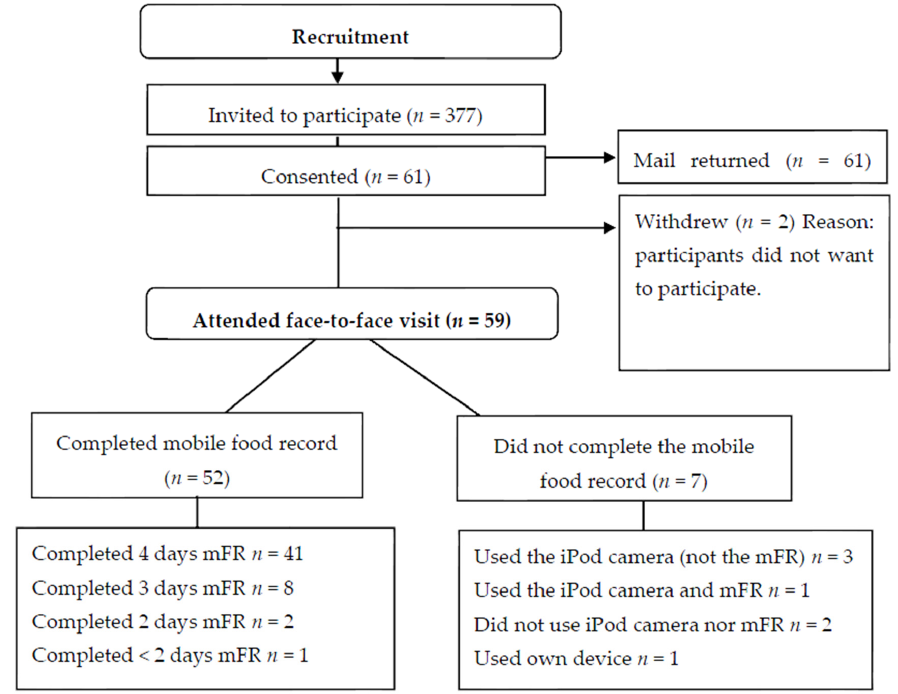
Figure 1. Data collection flowchart for the PANDs study.